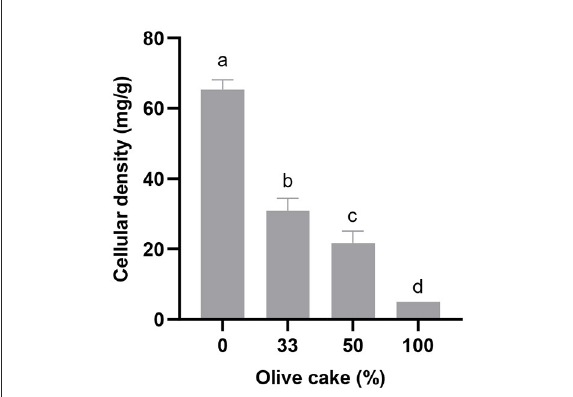
FIGURE1 Cellular density obtained after 2 days of SSF as a function of the percentage of olive cake in the substrate mixture. Bars with the same letter are not significantly different (p >